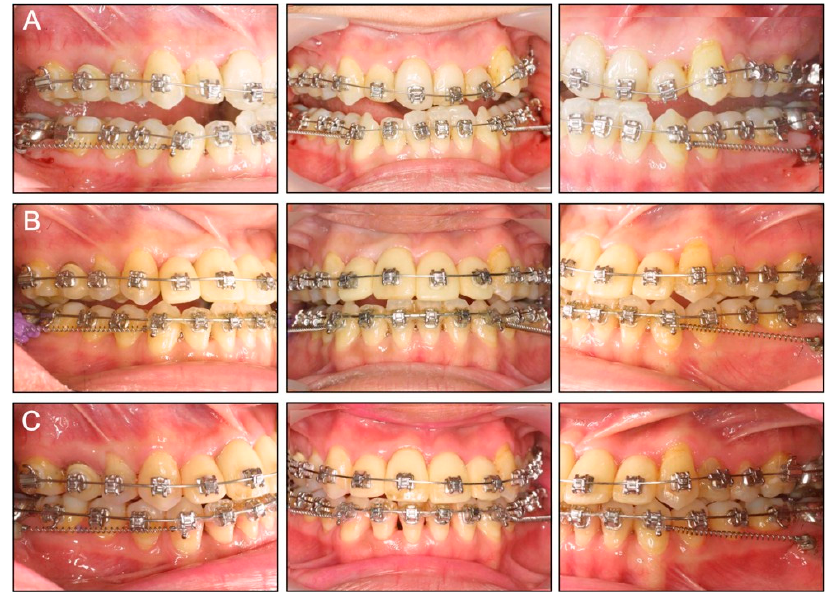
Figure 11. Case 2, Progressive records at ( A ) 2nd month ( B ) 4th month ( C ) 6th month show the correction of anterior crossbite and Class III malocclusion.